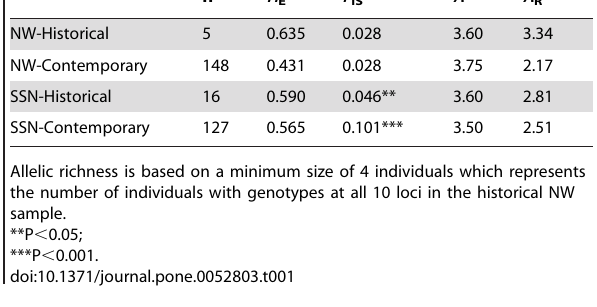
Table 2. Pairwise comparisons of genetic differentiation between samples with R ST above the diagonal and F ST below the